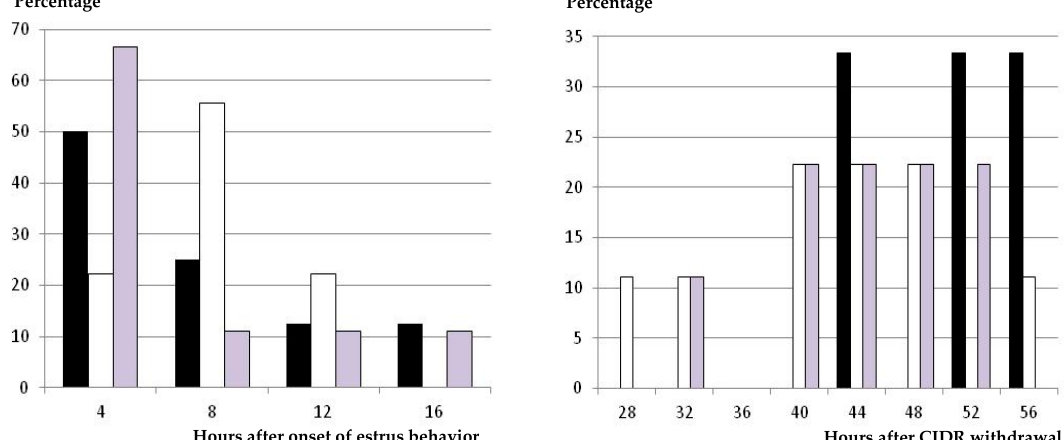
Figure 3. Distribution (percentage of animals) of time of onset of the preovulatory LH surge, in hours after estrus behavior (left hand) and after CIDR withdrawal (right hand), in ewes treated with a single i.m. dose of 400 IU of eCG at CIDR removal (group CIDR-eCG, white bars), with a single dose of GnRH at 56 h after CIDR removal (group CIDR-GnRH, grey bars), and with two GnRH doses—one at CIDR insertion and one 56 h after CIDR removal (group GnRH-CIDR-GnRH, black bars).